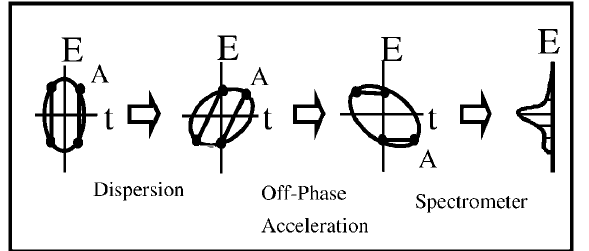
FIG. 1. A linear transformation of the longitudinal phase space can transform a temporal slice of the bunch, such as the segment containing point A, into a slice of the final energy distribution imaged in the spectrometer. Stretching of the phase space in the dispersive section allows an off-phase accelerator to remove the initial energy spread from the slice.